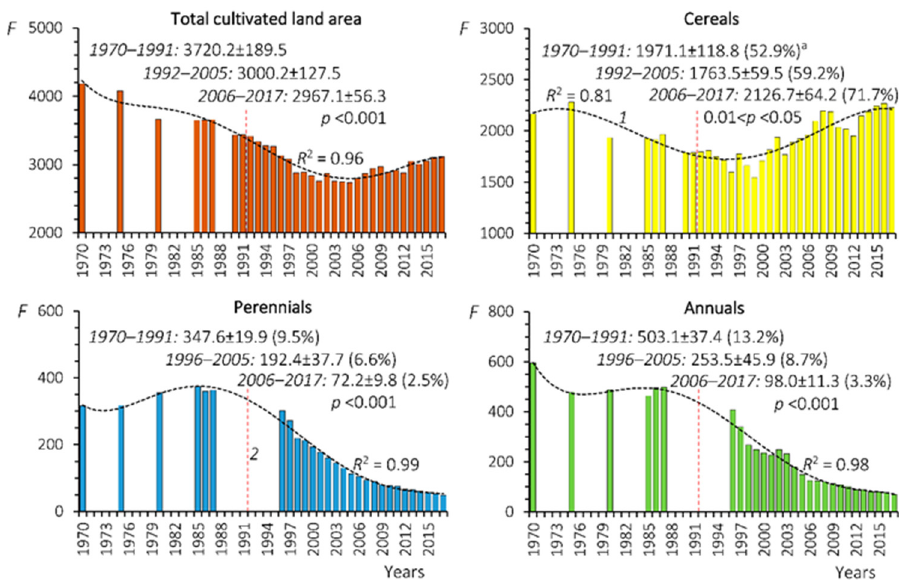
Figure 13. Changes in cultivated land area ( F , × 10 3 ha) in the Stavropol Krai (SW Russia) during 1970–2017. R 2 —the coefficient of approximation for the fifth-degree polynomial trend line ( 1 ); 2 —the time border between the former USSR and the Russian Federation; p —the probability of statistically significant difference for the indicated averaged values between 1970–1991 and 2006–2017 (the Student’s t -test). a The share of area under the corresponding crop in the region’s total sowing fund in the corresponding period.